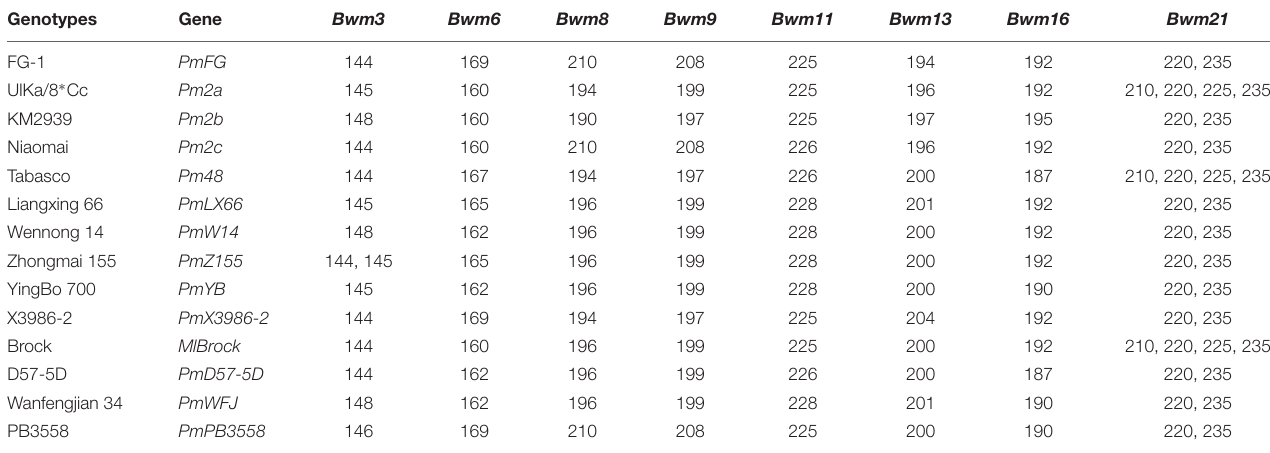
TABLE 4 | Sizes of the linked marker alleles of FG-1 and the wheat genotypes with documented Pm genes at or near Pm2 locus on chromosome arm 5DS using SNP-derived markers of PmFG . Genotypes